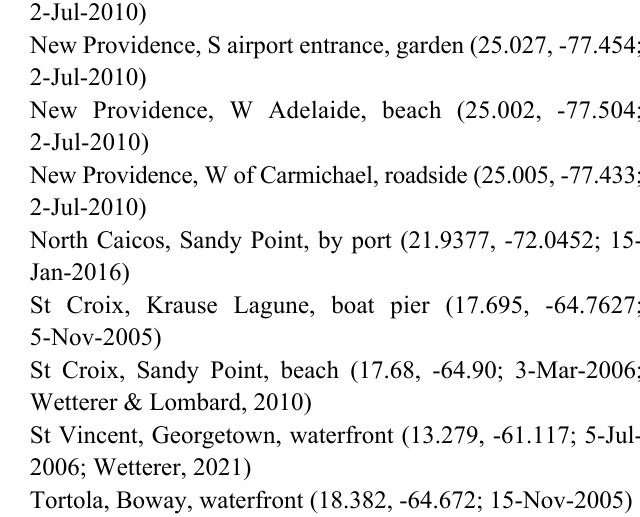
Table 1 . Earliest known records for Nylanderia bourbonica from the New World. Unpublished specimen records include collector, museum source, and site. + = no previously published records. * = indoor populations. MCZ = Museum of Comparative